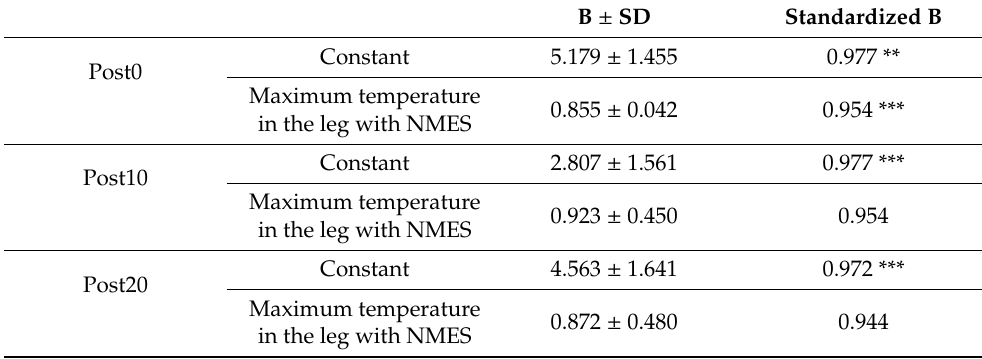
Table 2. Typified coe ffi cients (B) and their probability values for the application moments of NMES (Post0, Post10, and